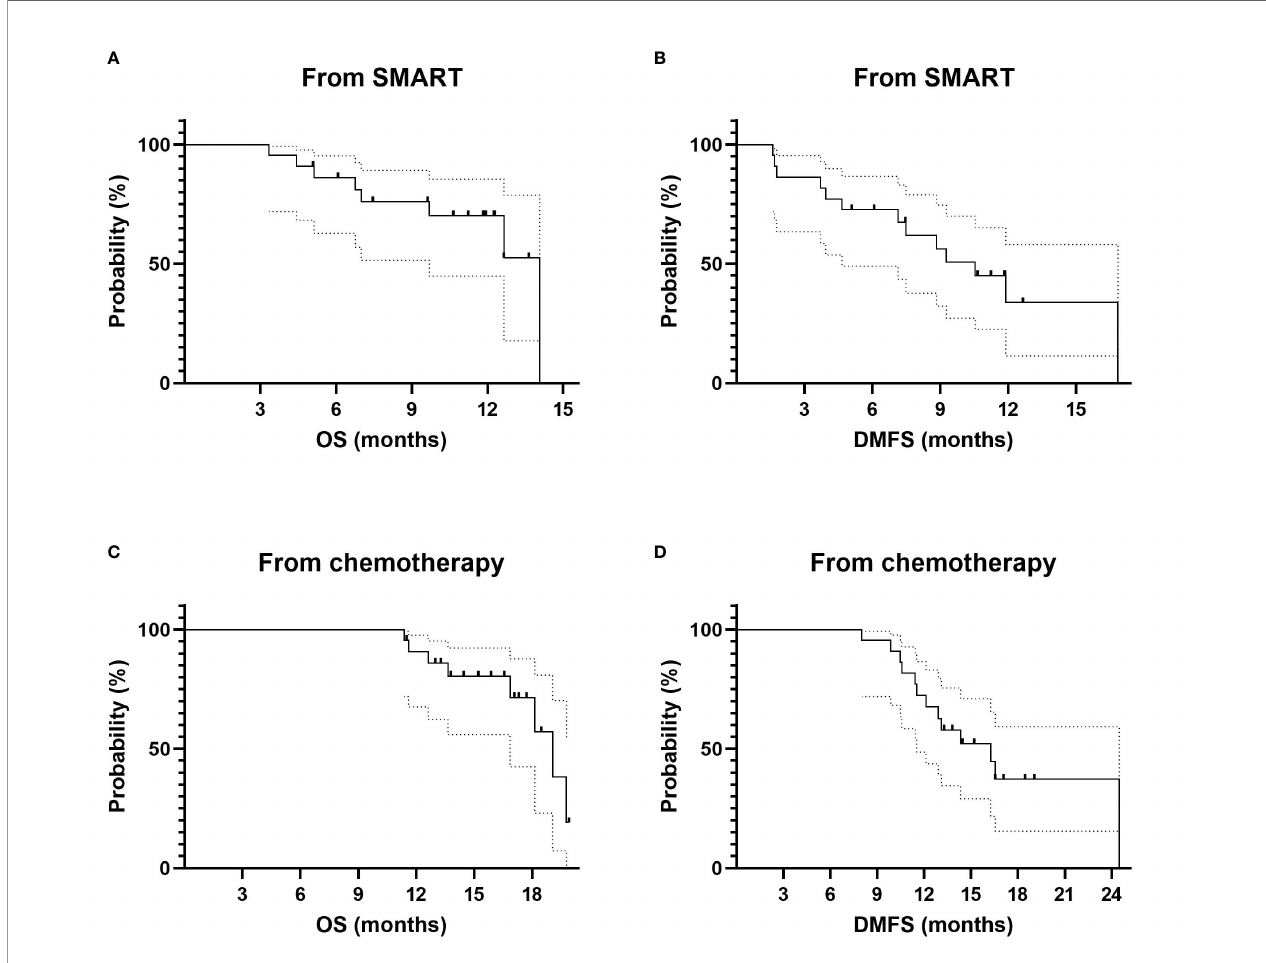
FIGURE 4 | Survival data for LAPC and BRPC patients: comparison between resected and unresected patients. (A) OS from SMART completion. (B) DMFS from SMART completion. (C) OS from chemotherapy start. (D) DMFS from chemotherapy start. LAPC, locally advanced pancreatic cancer; BRPC, borderline resectable pancreatic cancer; OS, overall survival; SMART, stereotactic MR-guided adaptive radiotherapy; DMFS, distant metastasis-free